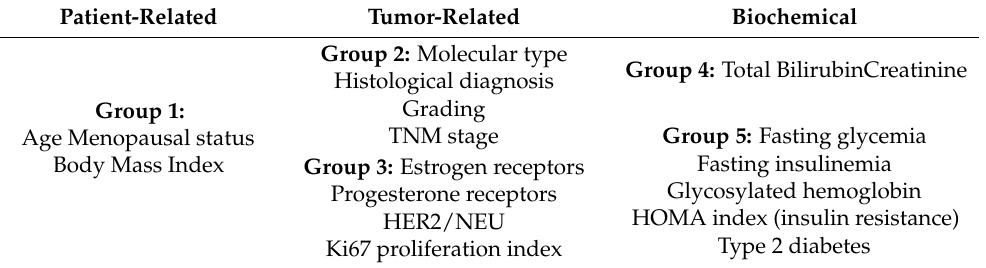
Table 5. Features included in the